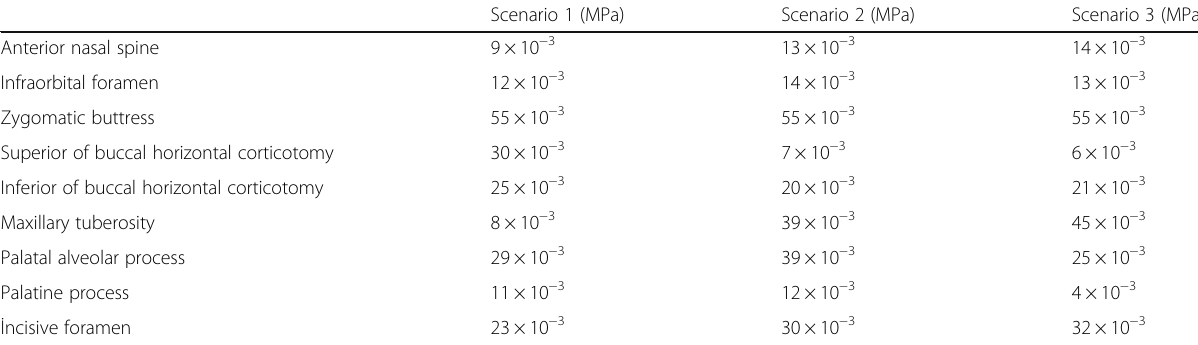
Table 2 Von Mises stress values over the cortical bone